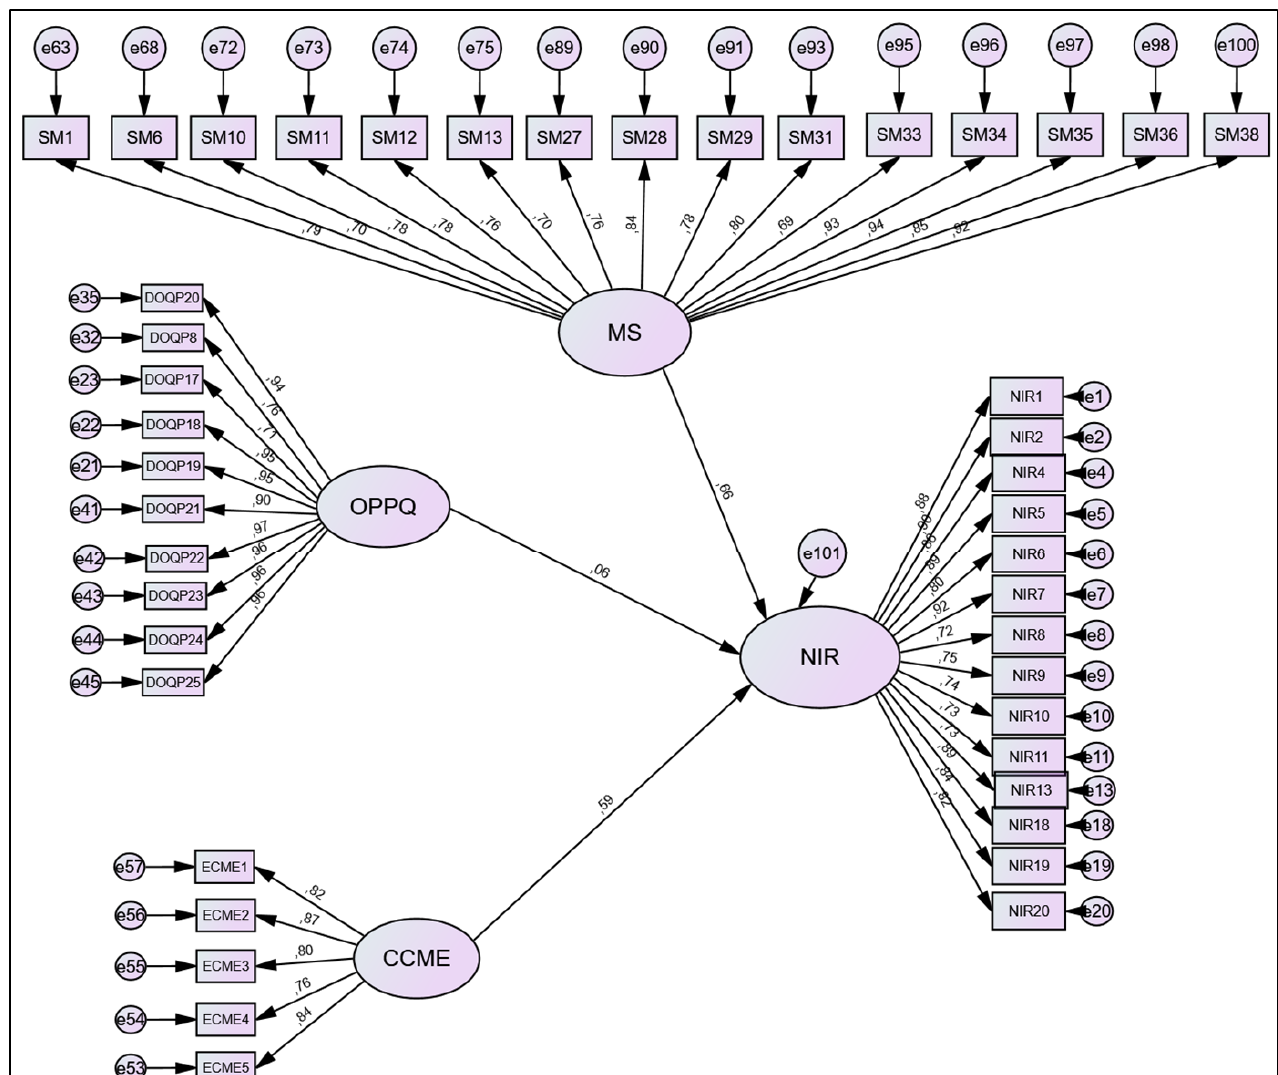
Figure 2. Final research model.